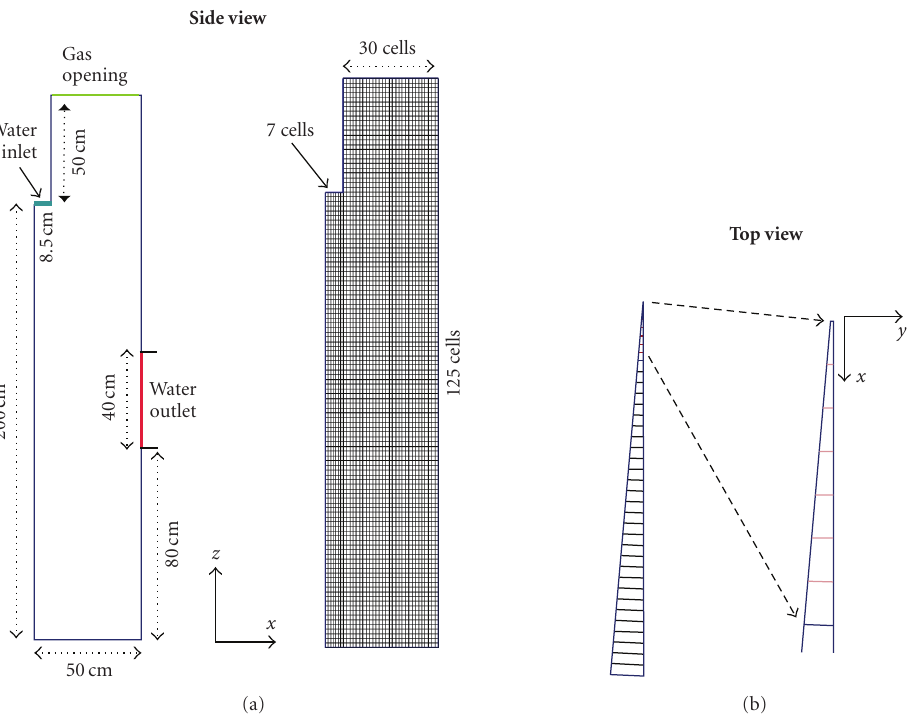
Figure 3: Section (five degrees) of the cylindrical tank; geometry and